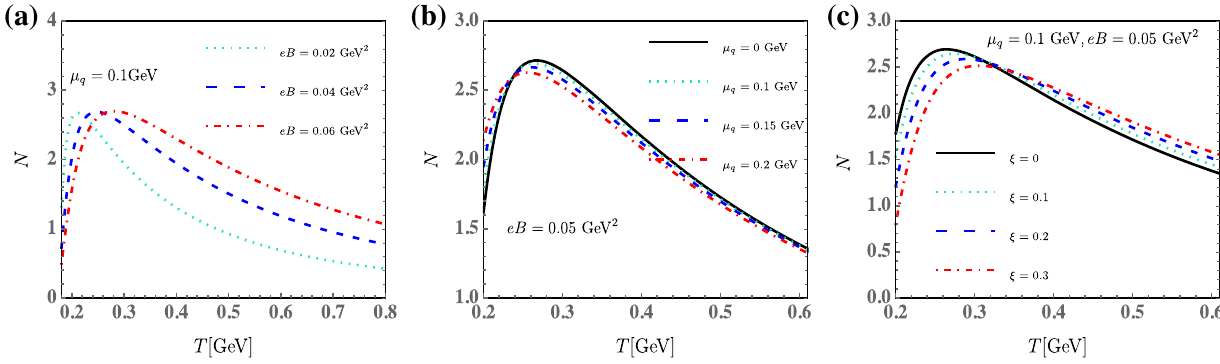
Fig. 5 a The temperature dependence of the Nernst signal ( N ) for μ = 0 . 1 GeV at different magnetic fields, namely eB = 0.02 GeV 2 q (cyandottedline),0.04GeV 2 (bluedashedline),0.06GeV 2 (reddotted- dashed line). b The temperature dependence of N for eB = 0 . 05 GeV 2 at μ q = 0 GeV (black solid line), 0.1 GeV (cyan dotted line), 0.15 GeV